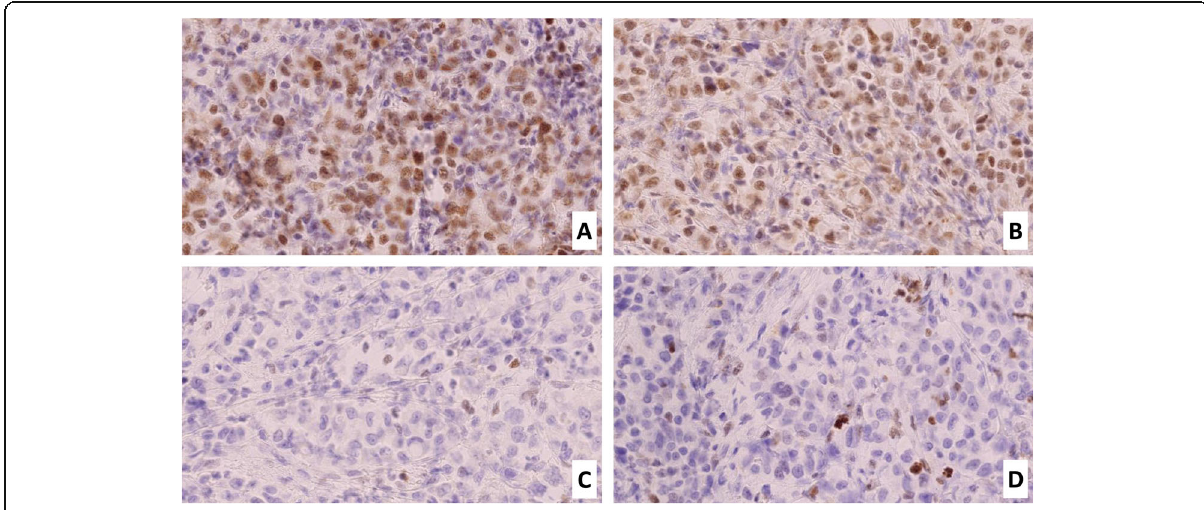
Fig. 5 Mismatch repair protein immunohistochemistry. A Diffuse nuclear expression of MLH1 (x20). B Diffuse nuclear expression of PMS2 (x20). C Loss of MSH2 expression, with positive internal control (x20). D Loss of MSH6 expression, with positive internal control